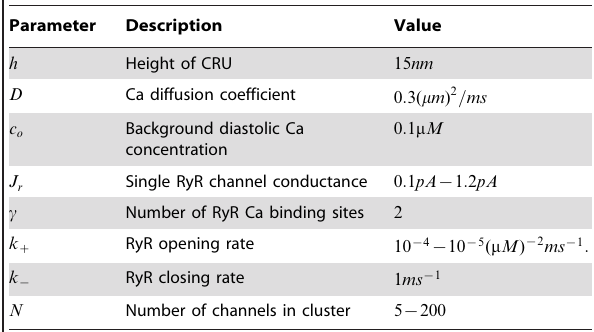
Fig. (2B) we plot the effective potential for two cluster sizes displaying mono and bistability. In the bistable regime the closed stable state at x o is separated from the fully open cluster at x 2 by a potential maxima at x 1 .